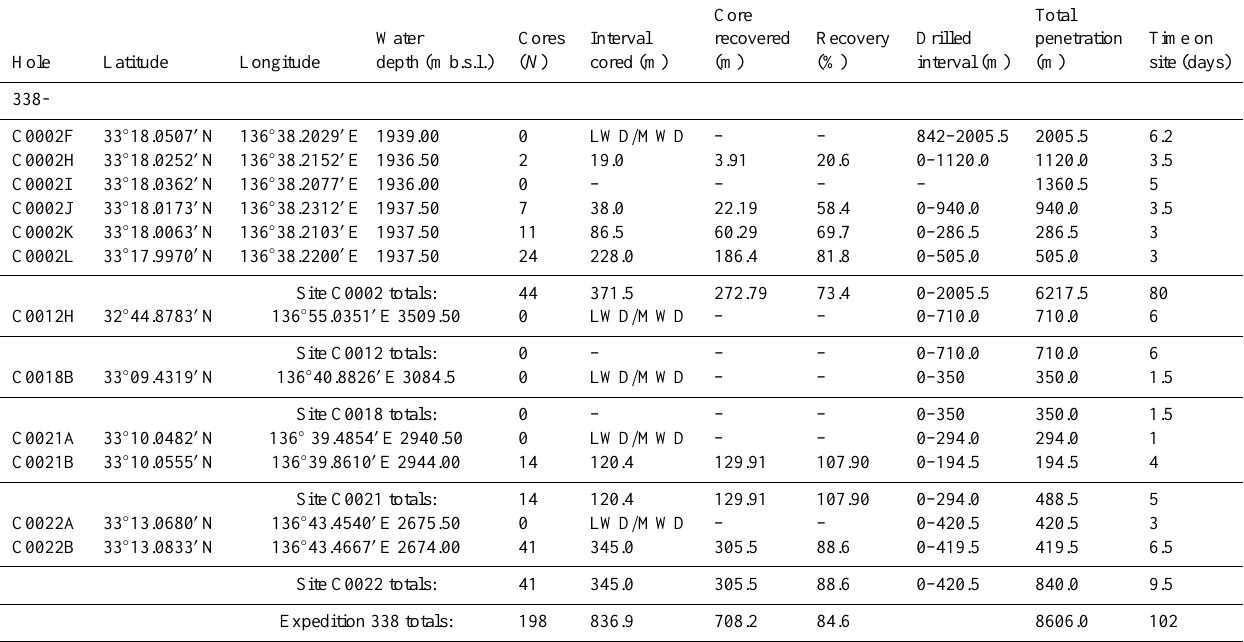
Table 1. Expedition 338 coring